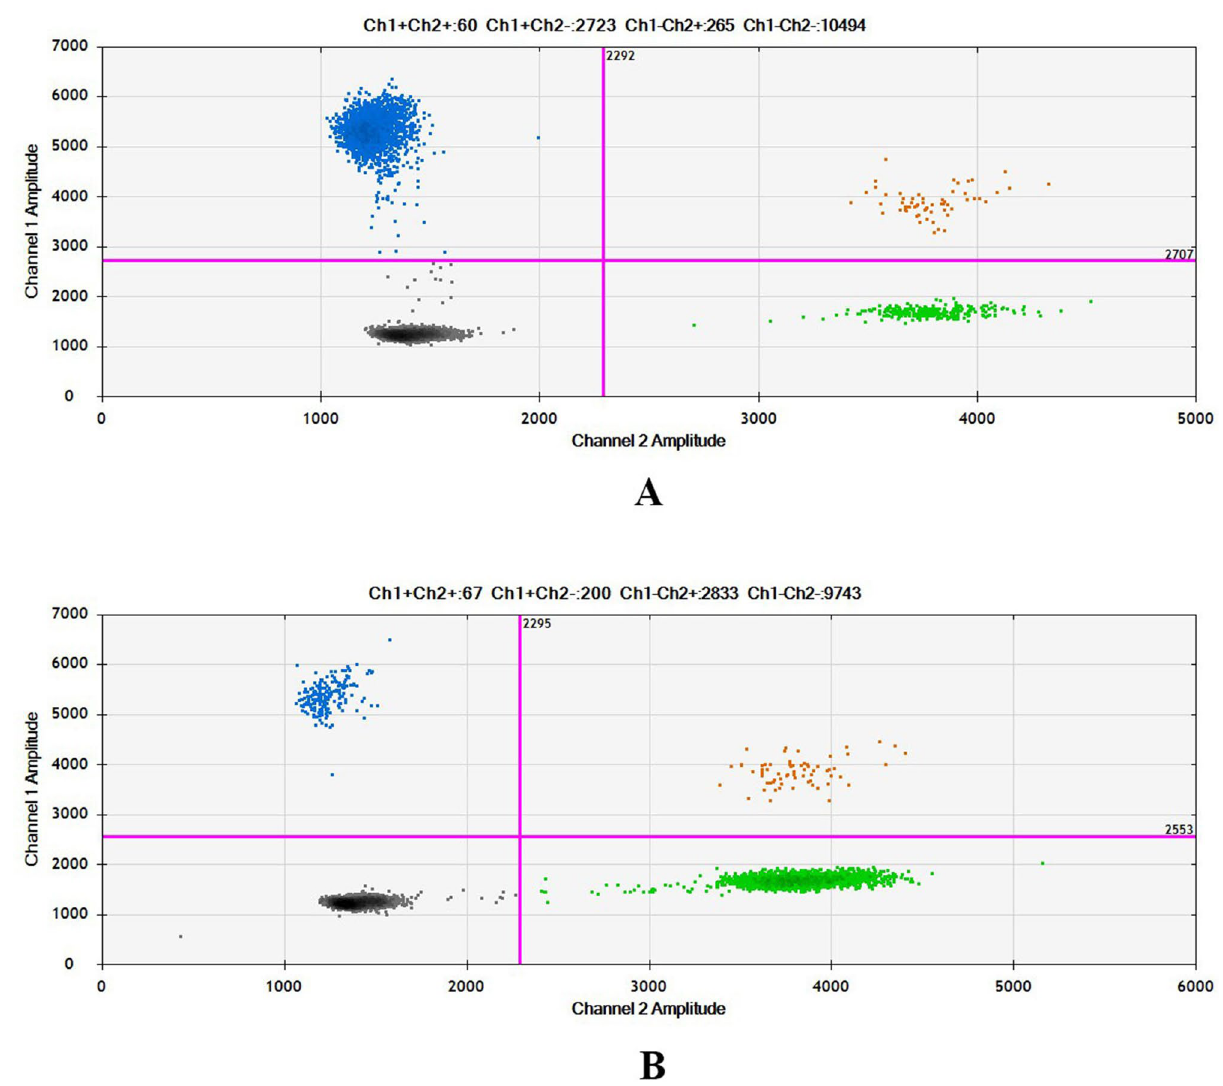
Figure 2. Quantitative results of the ddPCR system simultaneously detecting two bacterial strains. The 2D drop plots of Escherichia coli ATCC25922 and Staphylococcus aureus ATCC25923 by ddPCR system. ( A ) bacteria counts of Escherichia coli : bacteria counts of Staphylococcus aureus = 10:1 ( 6500:650 ), ( B ) bacteria counts of E. coli: bacteria counts of Staphylococcus aureus = 1:10 (650:6500).